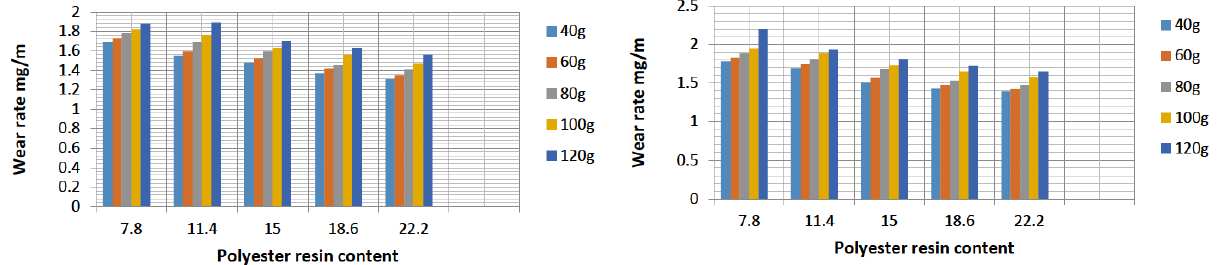
Figure 9: Wear rate of PKS /Polyester 420 µ m at 50 ∘ C